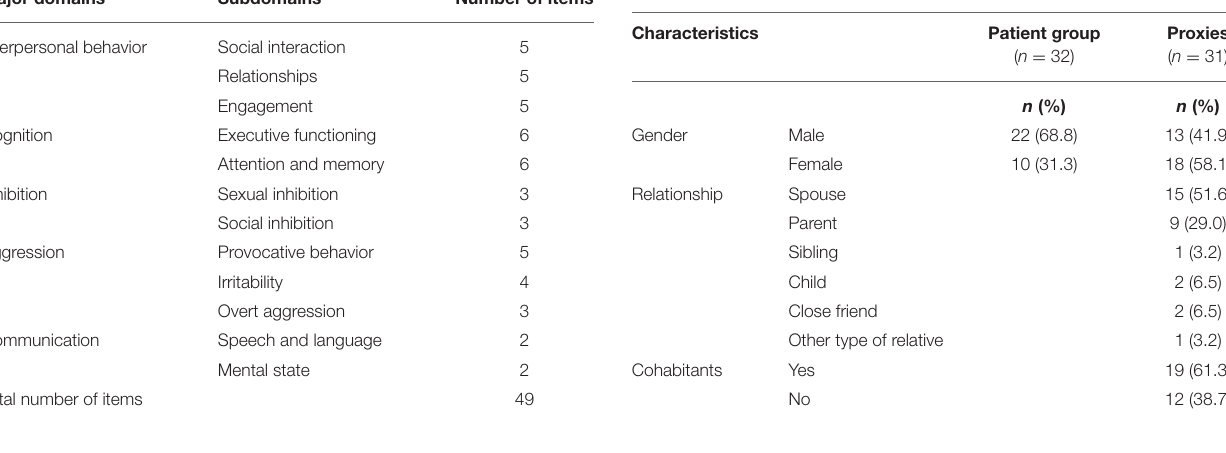
TABLE 2 | Demographic characteristics of patients and